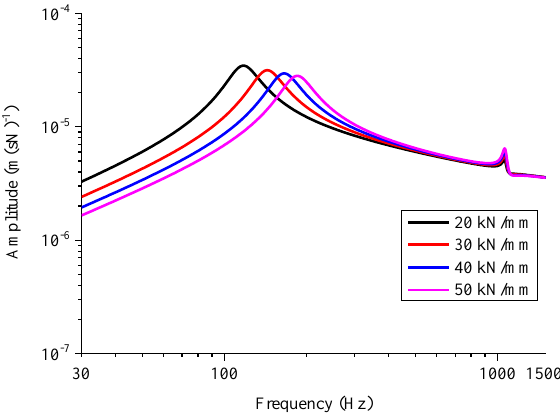
Figure 14. Influence of vertical fastener sti ff ness on direct mid-span rail mobility amplitude.